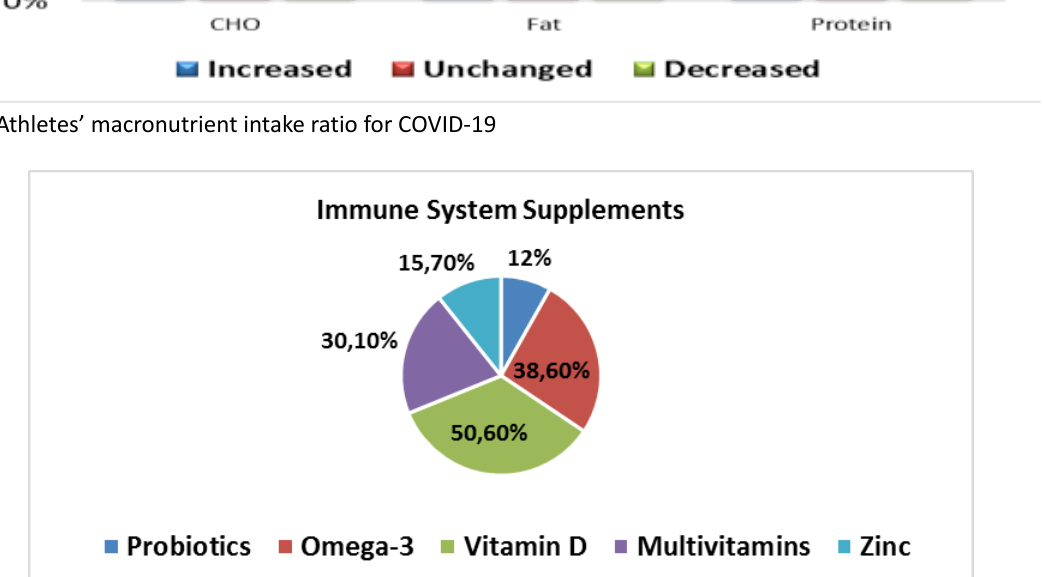
Figure 2. Supplements used by athletes to strengthen the immune Table 3. Analysis of mood profiles of the athletes during the social isolation period Mood States Profile Scale